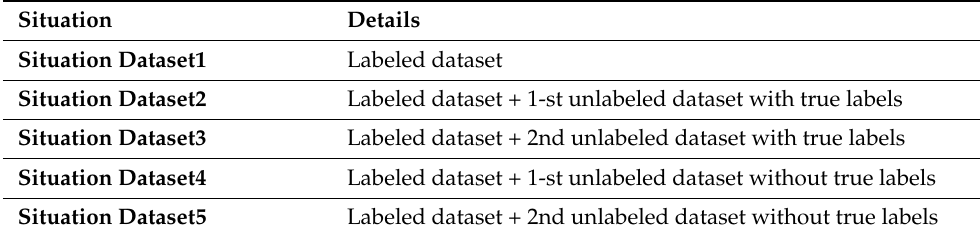
Table 3. The situations of the datasets that are used for training the